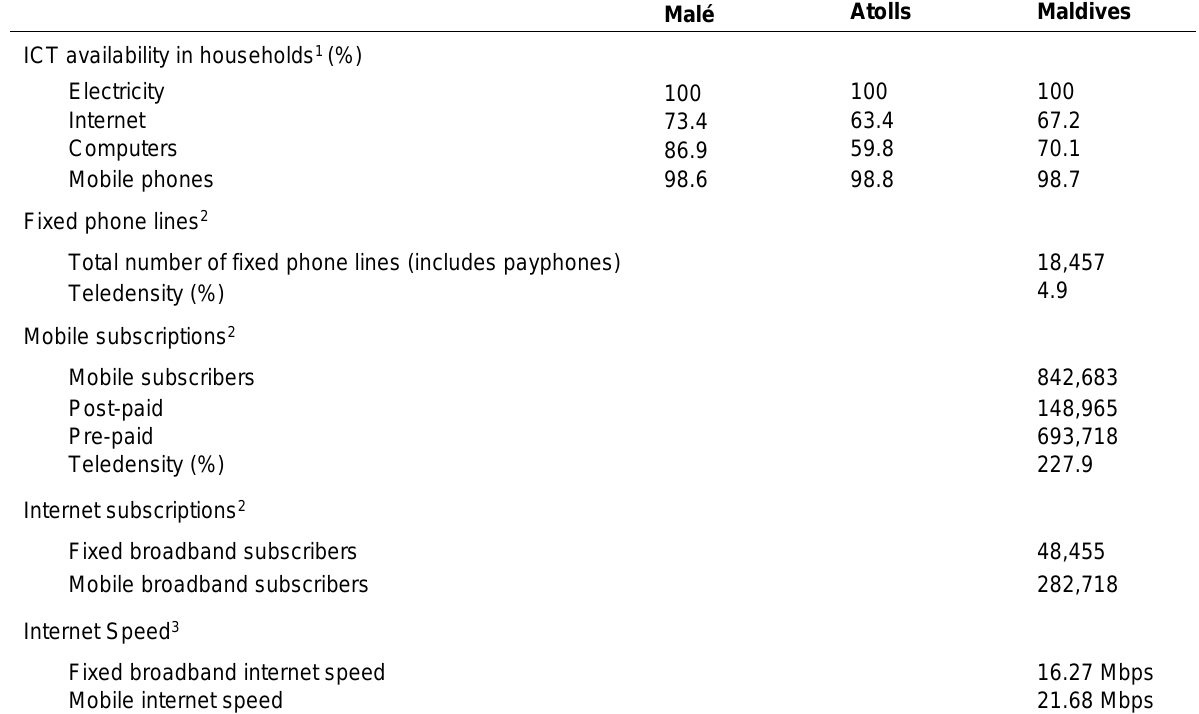
Table 2. Access to ICT in the